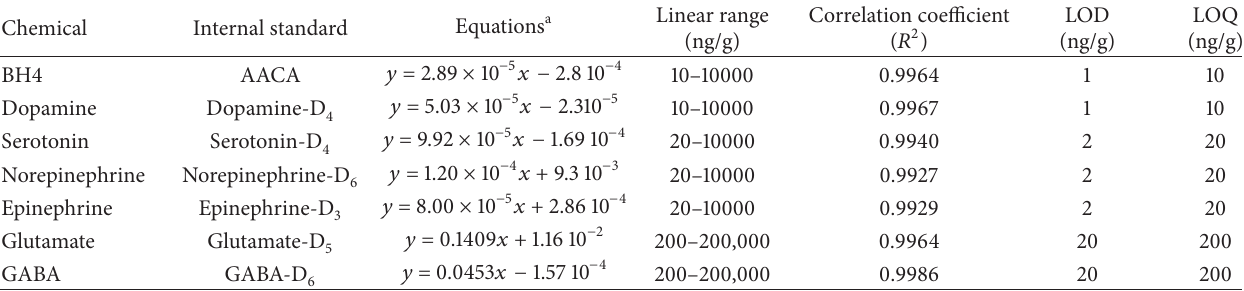
Table 1: The calibration of neurotransmitters by